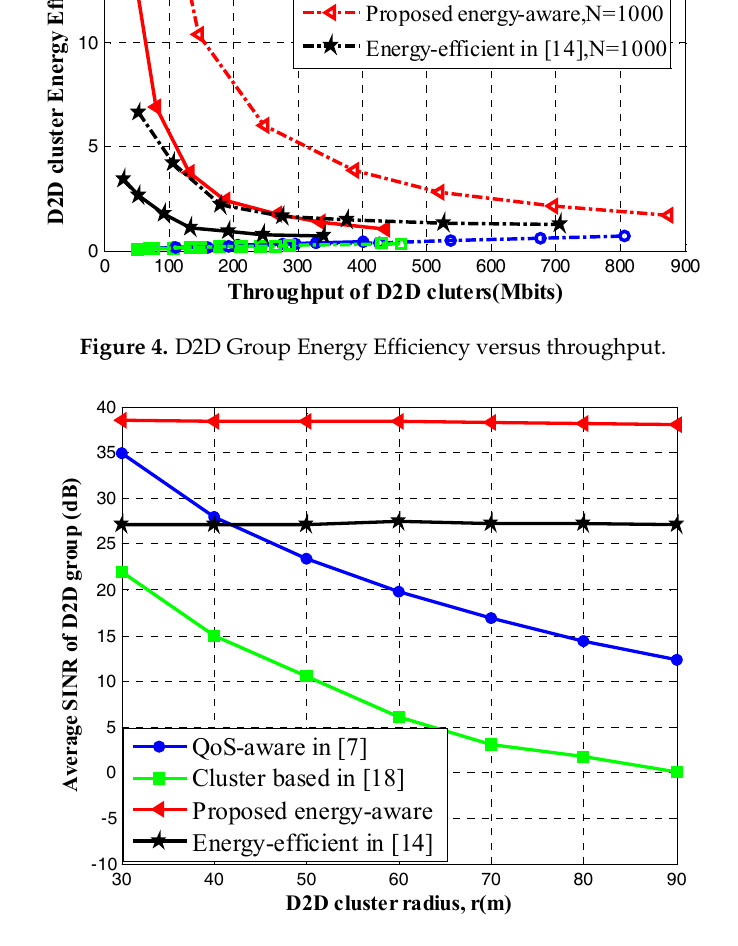
Figure 4. D2D Group Energy Efficiency versus throughput.